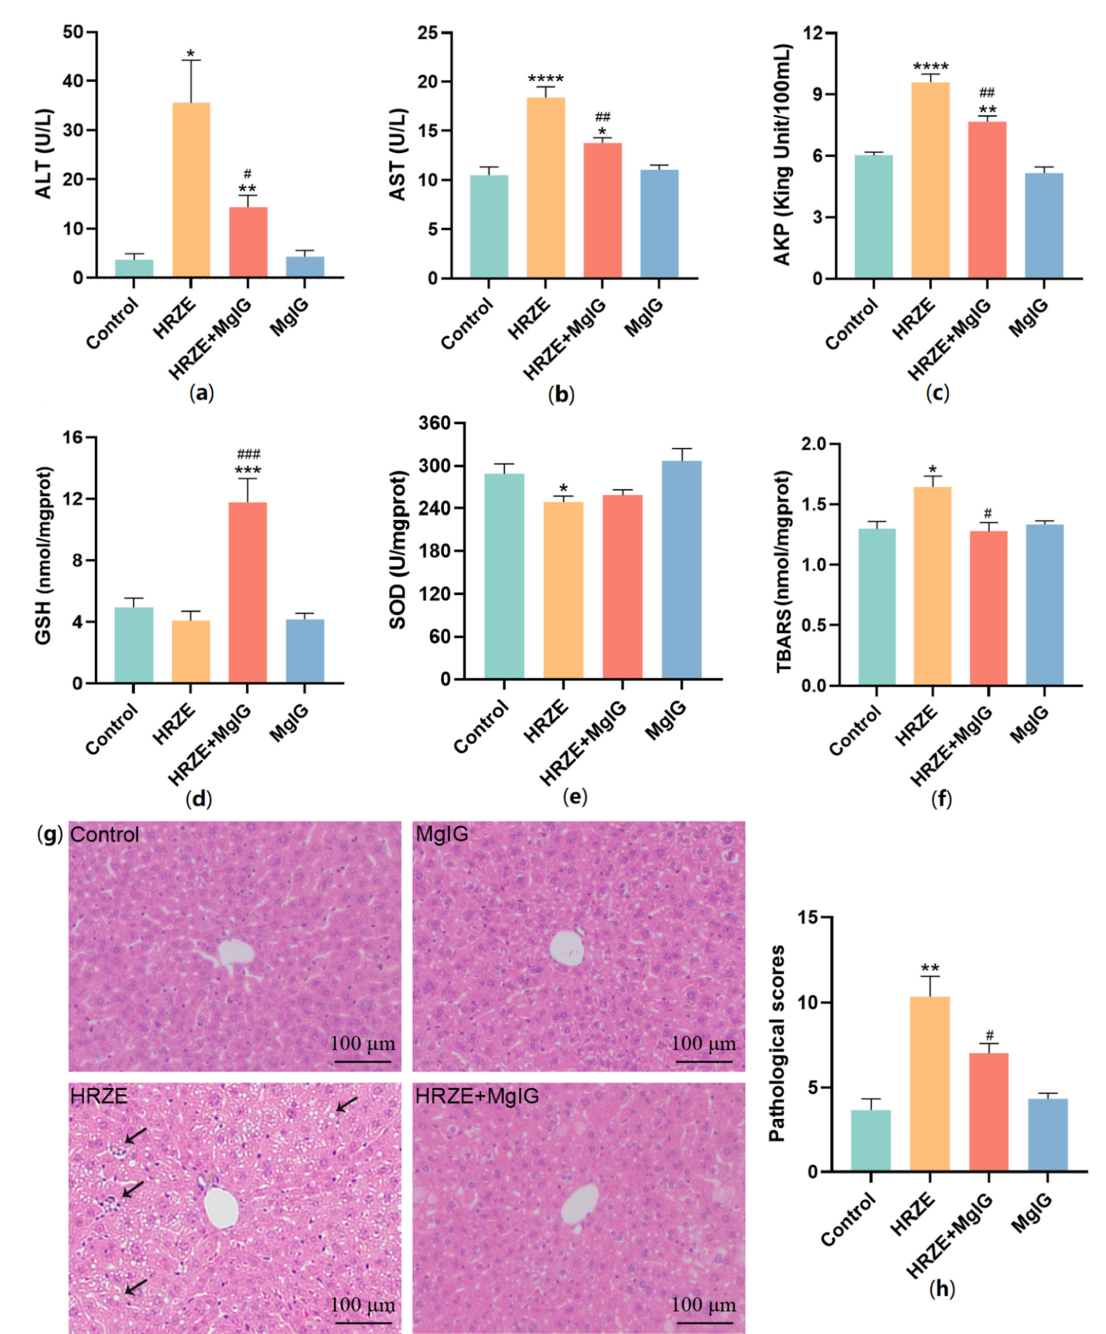
Figure 1. MgIG attenuates HRZE-induced liver injury. ( a ) ALT, ( b ) AST and ( c ) AKP levels of serum; ( d ) GSH, ( e ) SOD, and ( f ) TBARS (represents MDA level) levels of liver tissue homogenate in each group ( n = 6); ( g ) representative images of liver parenchyma H&E staining in each group, where arrows mean inflammatory cell infiltration and lipid vacuoles; ( h ) pathological scores of liver tissue ( n = 3). The data are presented as the means ± SEM. Compared with the control group: * p < 0.05, ** p < 0.01, *** p < 0.001, and **** p < 0.0001. Compared with the HRZE group: # p < 0.05, ## p < 0.01, and ### p <